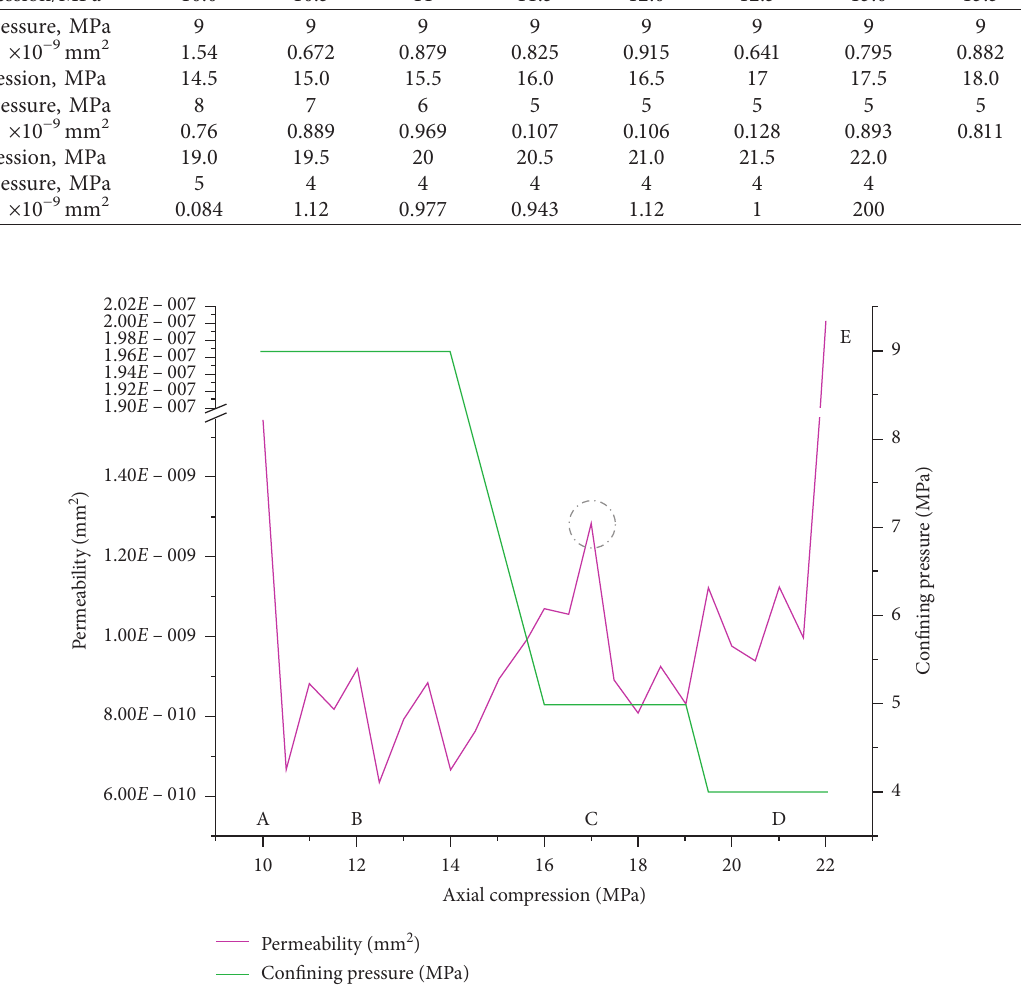
Figure 3: Relationship between permeability and stress state of MD-1 sandstone.